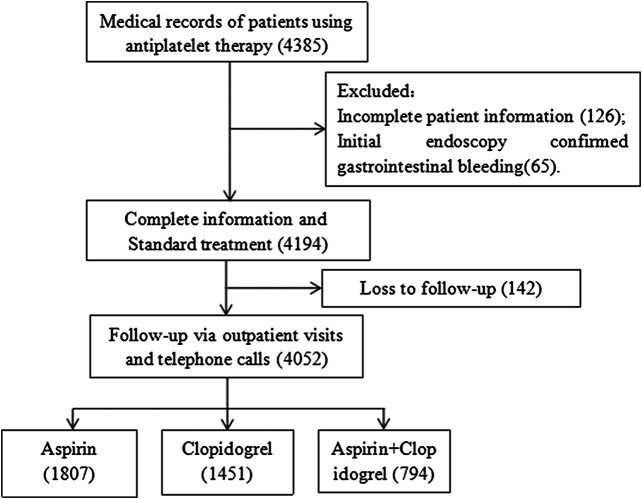
Flowchart of patient screening.